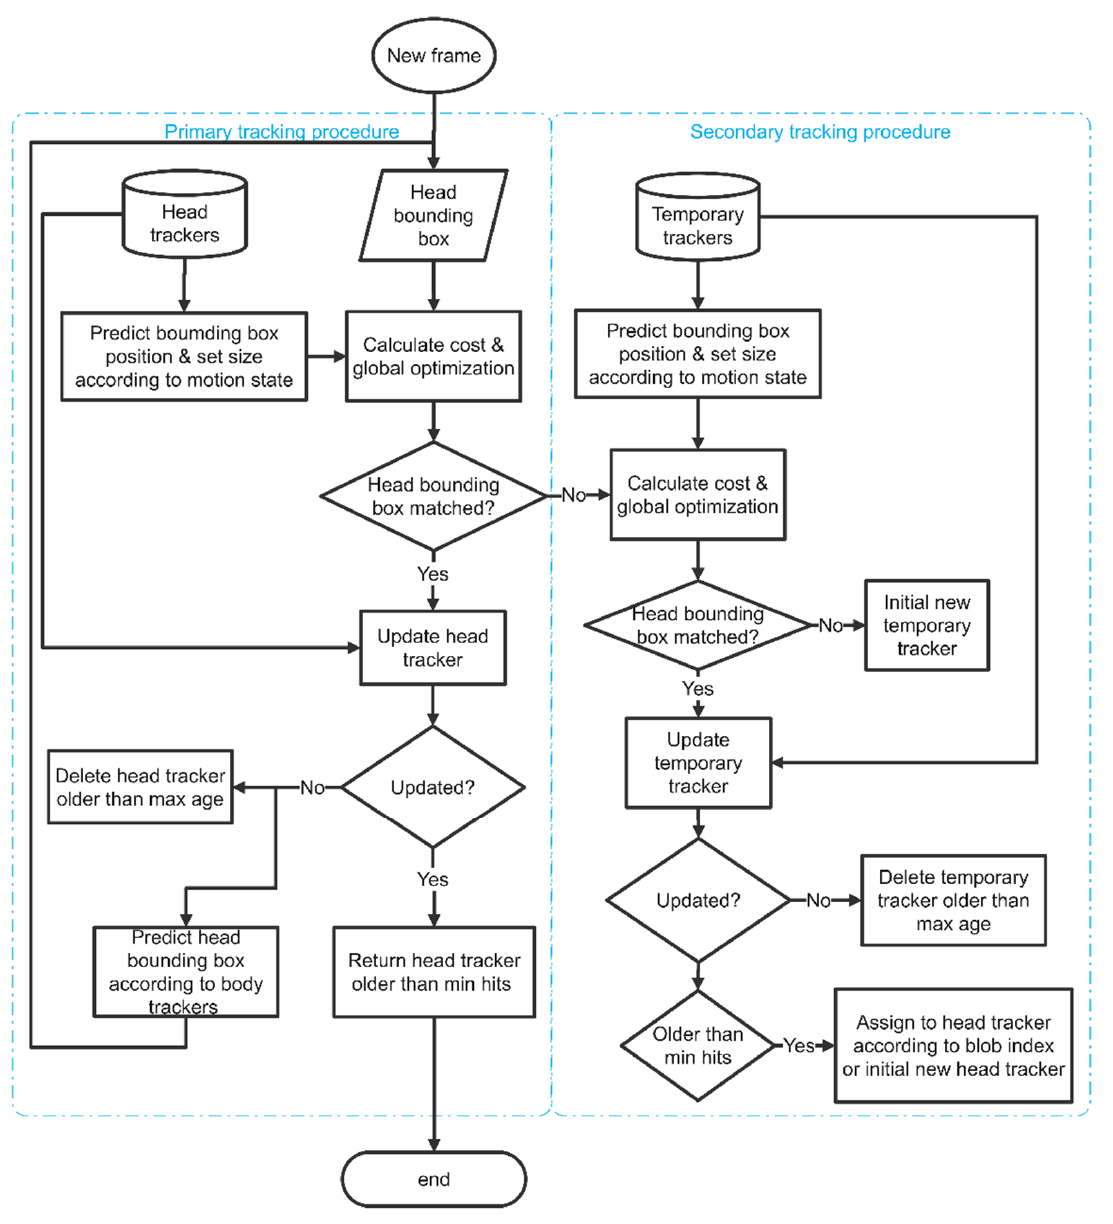
Figure 5. Flow chart of head tracking loop.